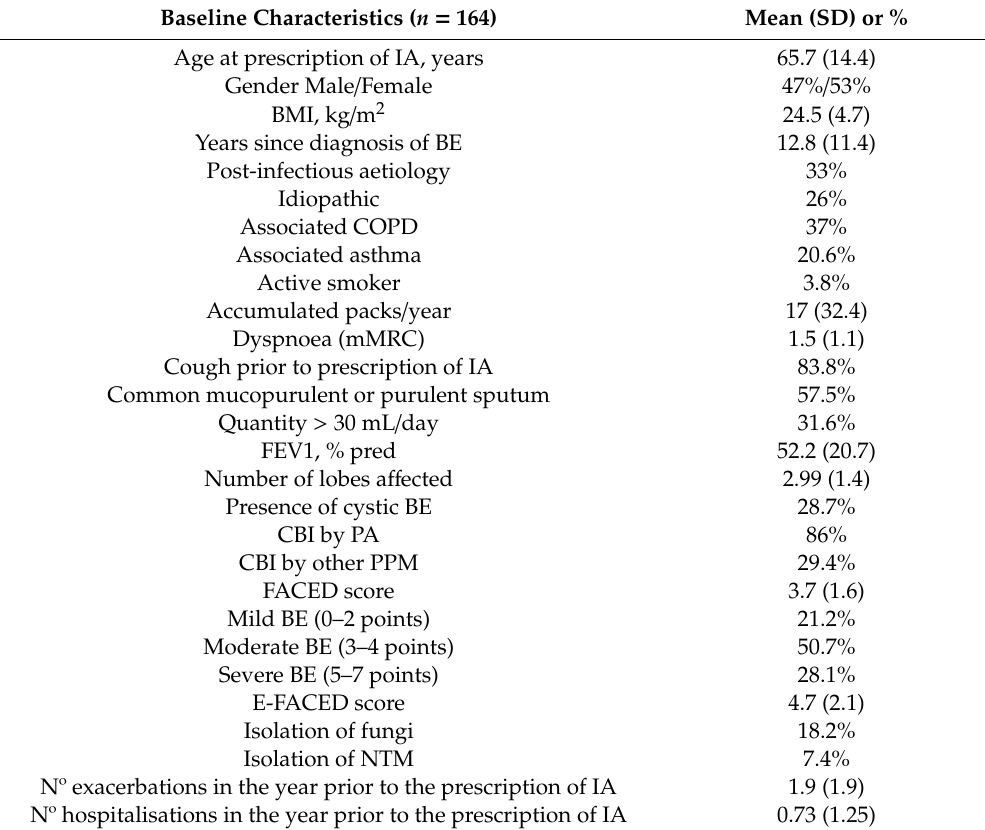
Table 3. Characteristics associated with the use of dry powder inhaled antibiotics.